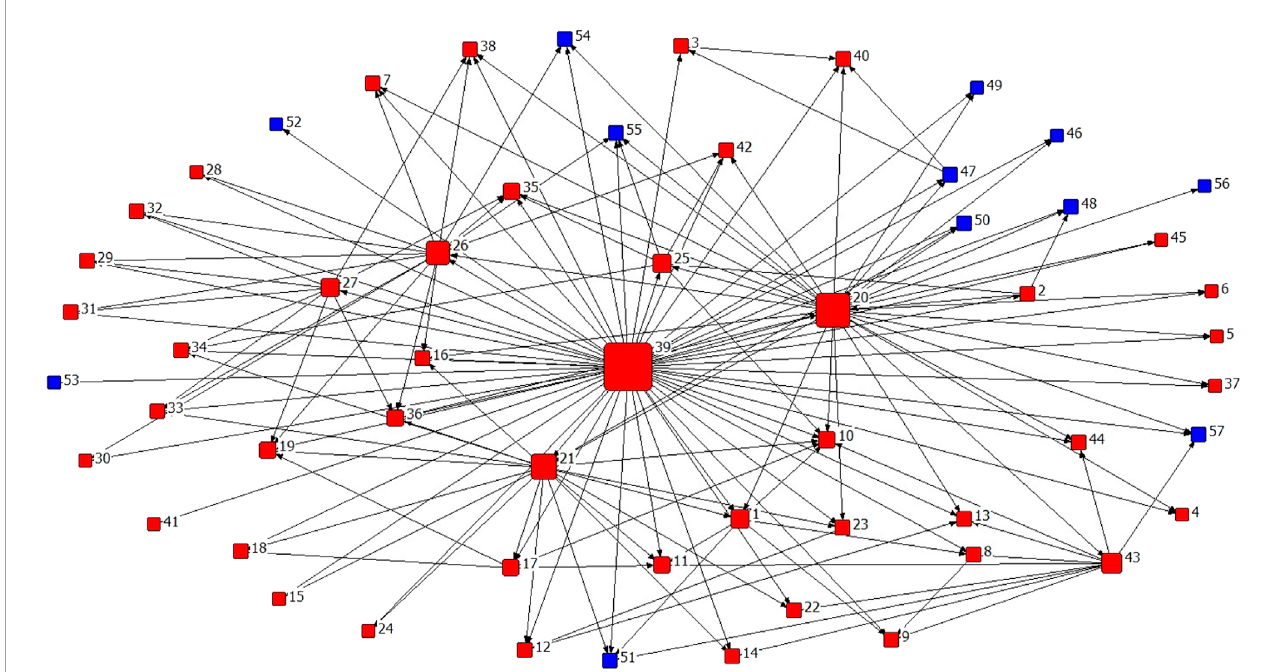
FIGURE 1 Marine industry carbon transfer network of China in 2020. Note: Nodes 46–57 in the figure represent the marine industry and are shown in blue, while nodes 1–45 represent the rest of the national industry and are shown in red. The importance of the nodes is initially expressed according to the number of carbon transfer associations between them, which is expressed as the size of the nodes, the larger the node the higher the degree.